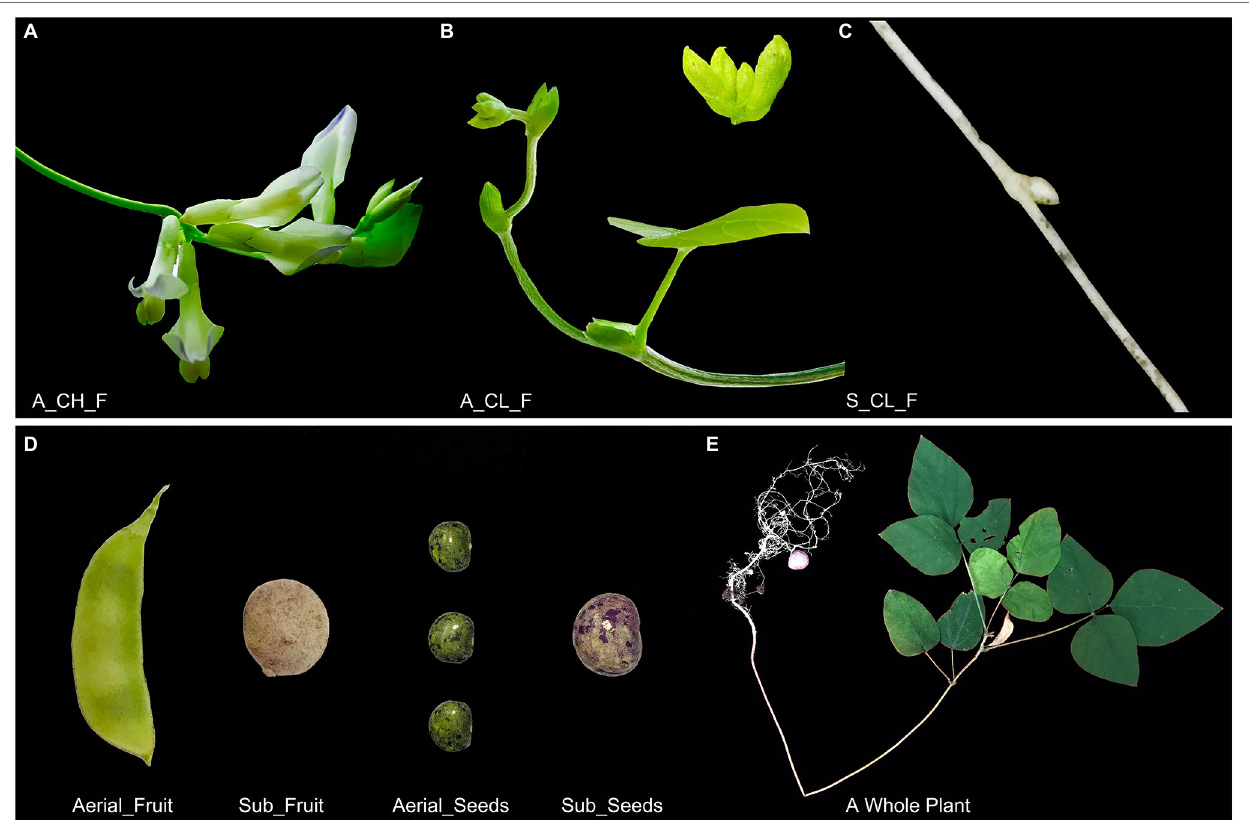
FIGURE 1 | Morphological features of the Amphicarpaea edgeworthii . (A) Aerial chasmogamous flower (A_CH_F). (B) Aerial cleistogamous flower (A_CL_F). (C) Subterranean cleistogamous flower (S_CL_F). (D) Fruit and seed: Left is the aerial fruit/seed (both aerial flowers produce fruit with the same phenotype); right is the subterranean fruit/seed. (E) A whole plant of wild A. edgeworthii